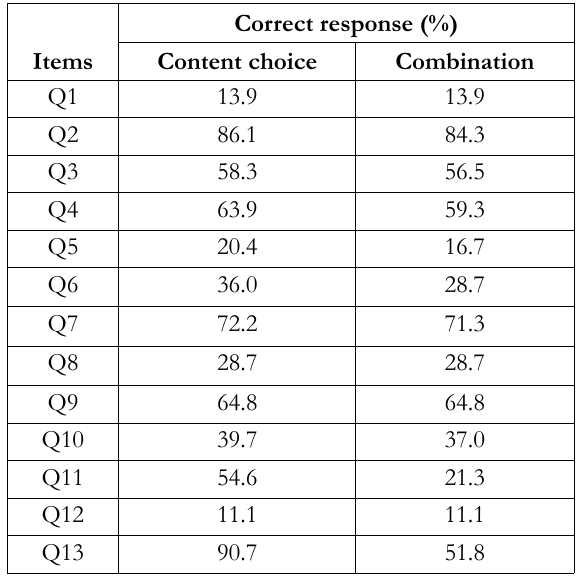
Table 7. Percentages of content choice and correct